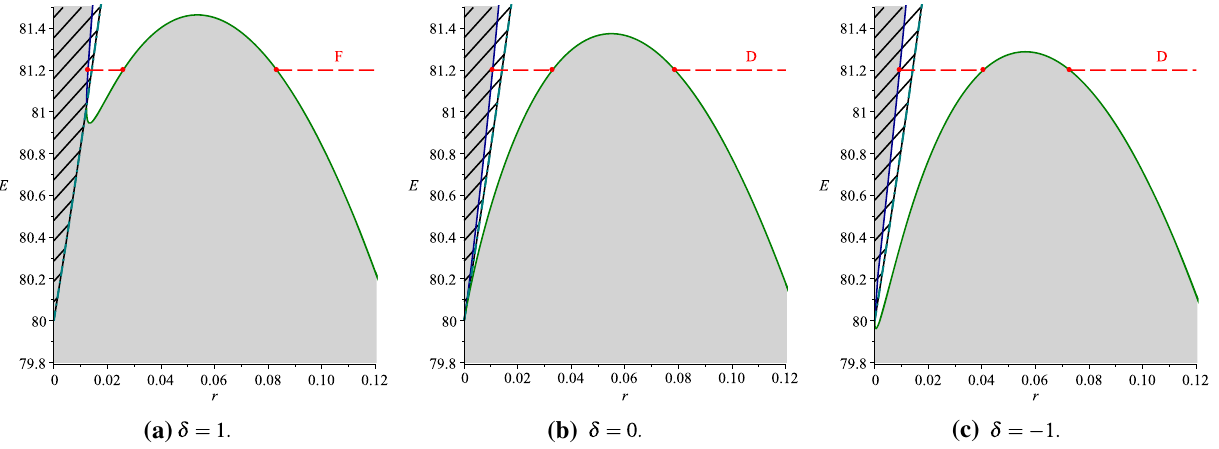
Fig. 4 Effective potential V ± of the r motion for varying δ and K = 0 , L = 80 , l = 1, which allows bound orbits of type D and F (see Table 1) behind the horizon. For a more detailed description see